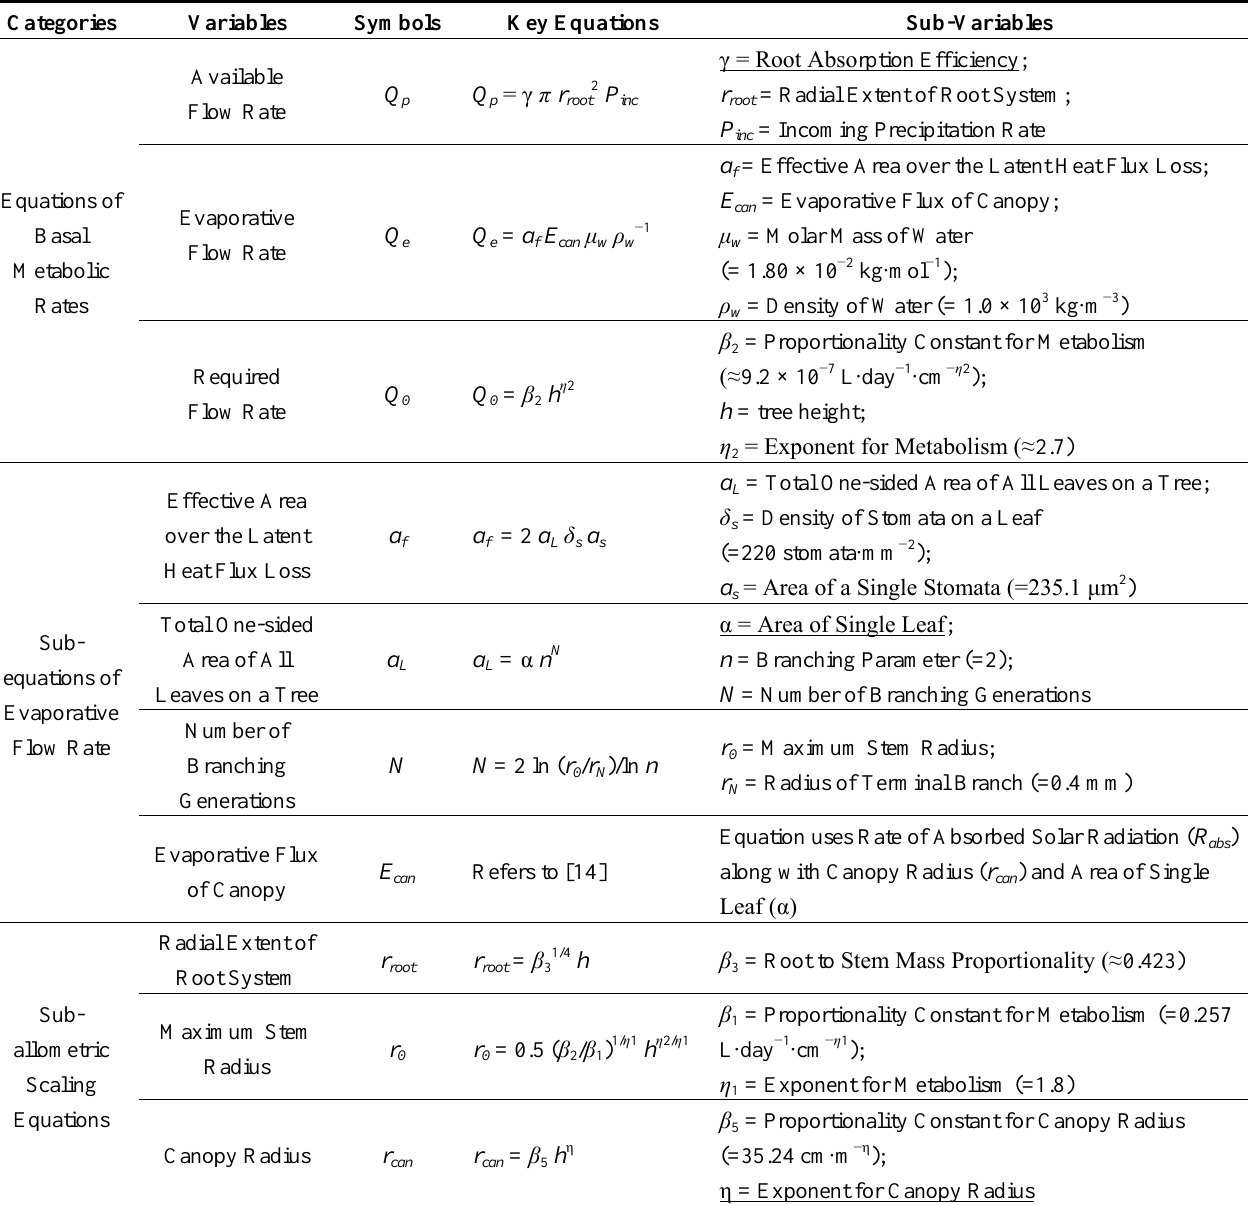
Table 1. Key equations of the Allometric Scaling and Resource Limitations (ASRL) model [14]. Underlined variables (α, η, and γ) are selected parameters in the ASRL model optimization, further explained in Section